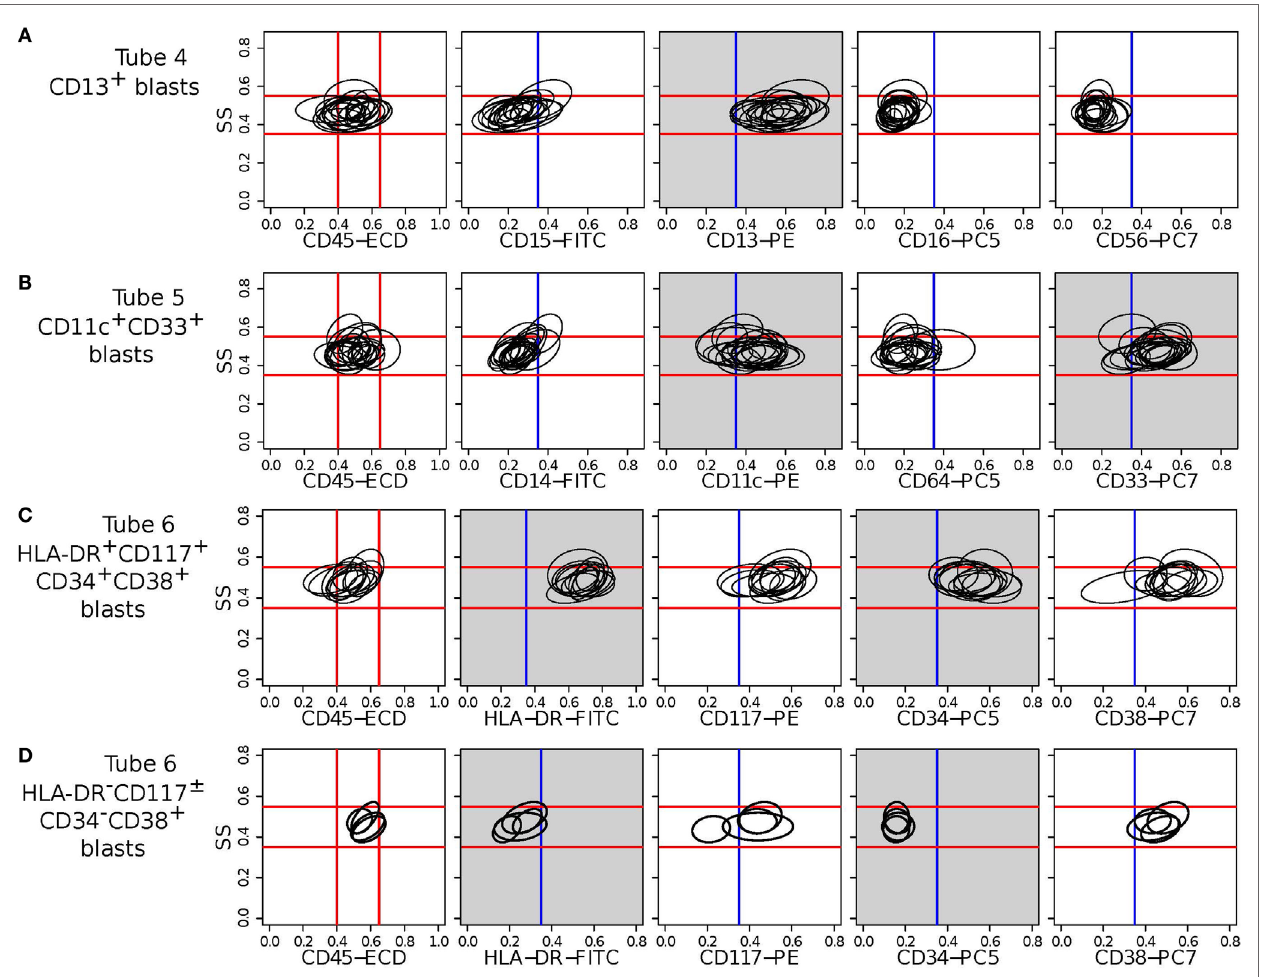
FigUre 13 | Bivariate contour plots (side scatter vs. individual marker) for two meta-clusters (one in each row) indicative of aMl . The ellipses in a subplot denote the 95th quantile contour lines of cell populations included in the corresponding meta-cluster. Myeloblast cells have medium side scatter (SS) and CD45 expressions. The red lines indicate approximate myeloblast boundaries (located on the left-most subfigures in each row and extended horizontally to the subfigures on the right) and confirm that these meta-clusters represent immunophenotypes of myeloblast cells. Blue vertical lines denote the ± boundaries of a marker. Gray subplots show contour plots of dominant markers defining the meta-cluster in a row. (a) CD13 + CD56 – meta-cluster shared by 17 AML samples in Tube 4. (B) CD4 – CD11c + CD64 – CD33 + meta-cluster shared by 18 AML samples in Tube 5. (c) HLA-DR + CD117 + CD34 + CD38 + meta-cluster shared by 11 AML